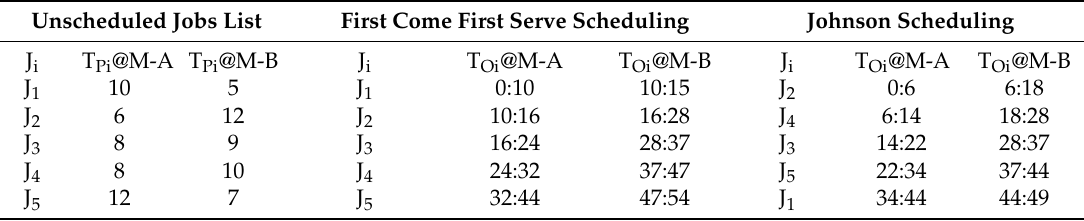
Table 1. Johnson Scheduling vs. First Come First Serve